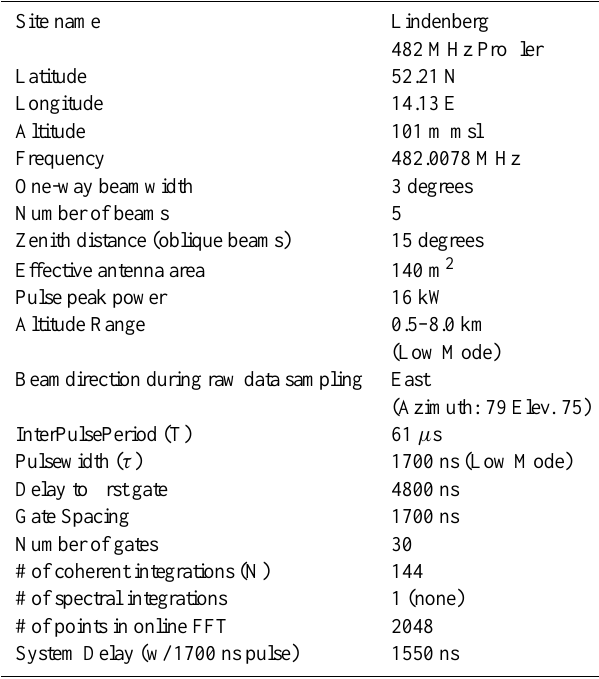
Table 1. Technical specification of RWP and radar operating